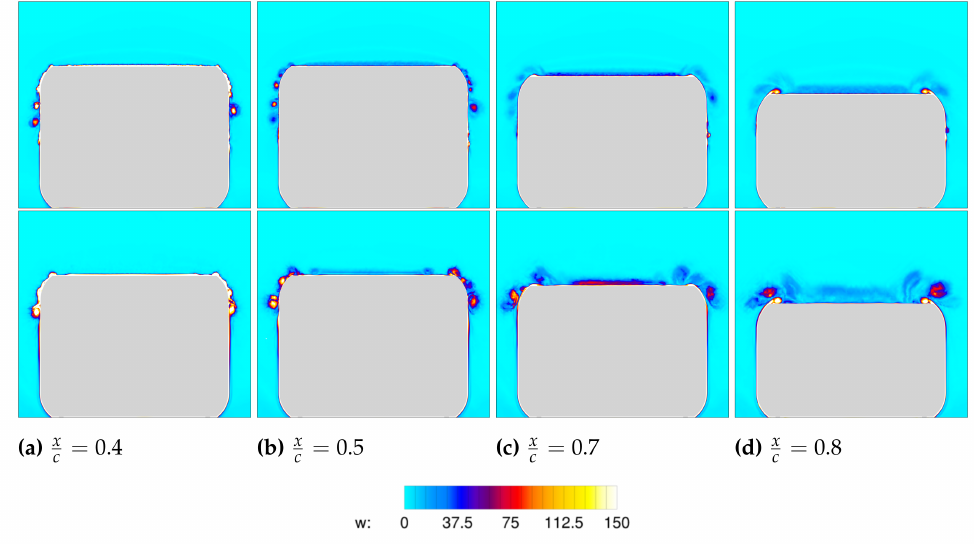
Figure 11. Vorticity contour comparison along X-normal planes: ( a ) x / c = 0.4, ( b ) x / c = 0.5, ( c ) x / c = 0.7 and ( d ) x / c = 0.8 . ( Top ) HCP5; ( Bottom )